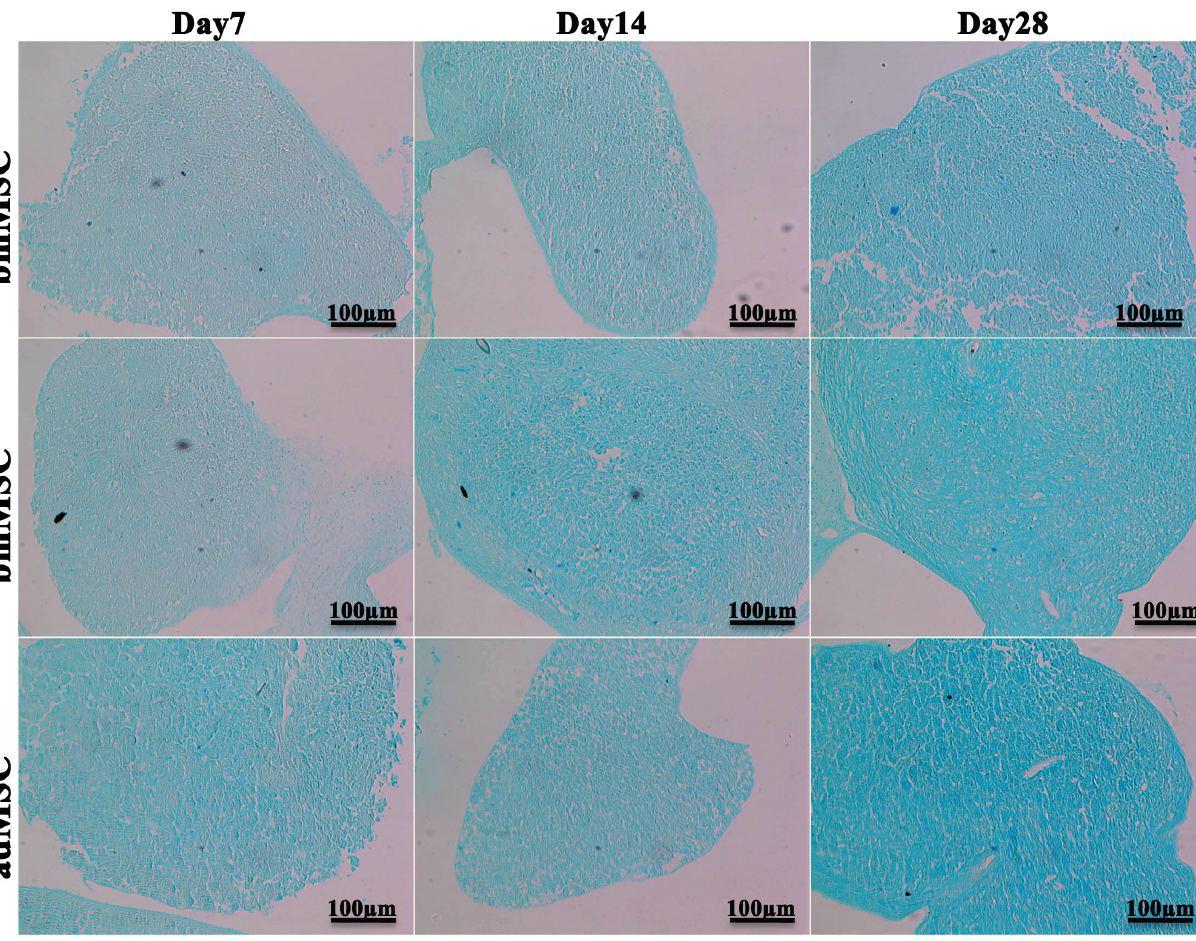
Figure 5. Alcian blue staining of bmMSC CD271 − , bmMSC CD271+ and adMSC CD271+ after 7, 14 and 28 days of chondrogenic